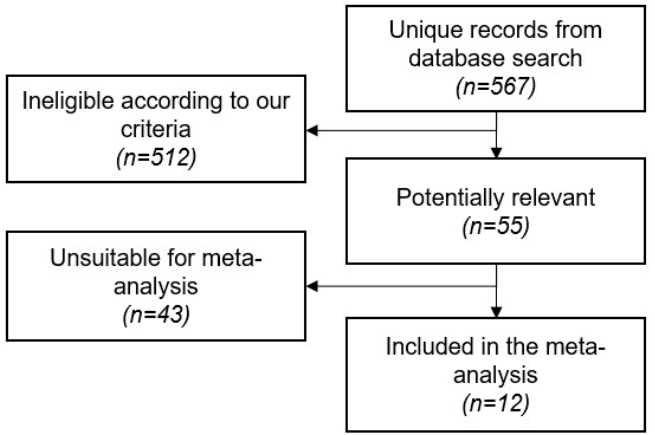
Figure 2. Summary of the number of screened, reviewed and included or excluded dendritic cell-based experimental anti-HIV-1 vaccines